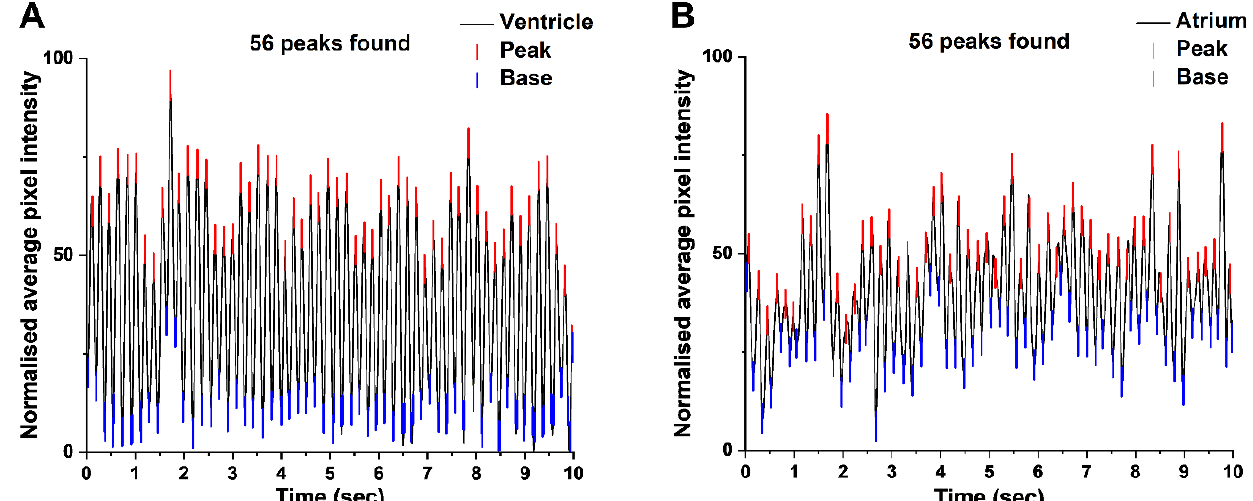
Figure 6. Representative LCGs of the ventricle ( A ) and atrium ( B ) of embryonic (just prior to parturition (JPP) stage) G. holbrooki heart. Graphs represent smoothed and normalised average PI. Quick Peak ( Gauss ) and peak analyser functions were used to identify the number of peaks. Red and blue bars mark the peak and base, respectively. In this instance, the numbers of peaks for both chambers were the same (56) and there were no significant differences at this stage and among others tested ( p ≥ 0.05, n = 20 for each developmental stage).